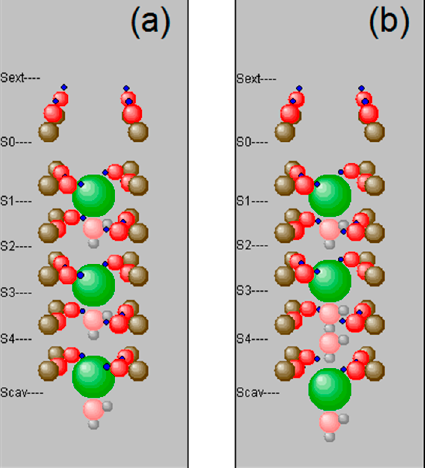
Figure 5. The two configurations (KWKWK) ( a ) and (KWWKWK) ( b ) as seen from inside to outside of the filter which caused the longest non-conductive state in the classical MD simulations.